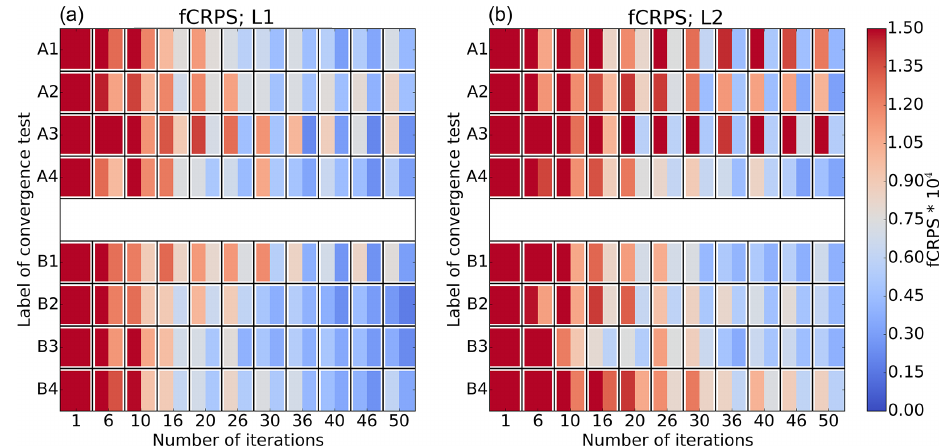
Figure 5. Evolution of θ 2 in repeated convergence tests with two selected forecast range – ensemble size combinations highlighted in Fig. 3. The level of complexity is (a) L1 and (b) L2. Tests A1 to A4 have been run with forecast range of 48h and ensemble size of 20 members, and tests B1 to B4 with 24h and 26 members. EPPES was used as an optimiser in these examples. Components of fCRPS have been calculated using Eqs. (3) and (4).